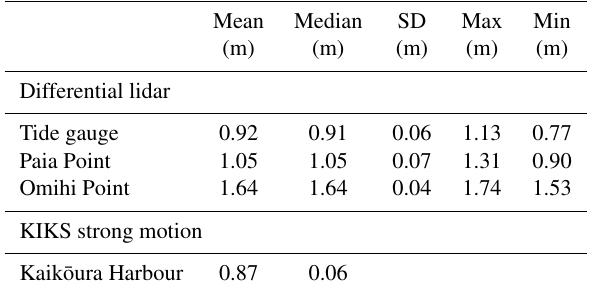
Table 6. Uplift calculated from differential lidar and strong-motion uplift estimated from the KIKS